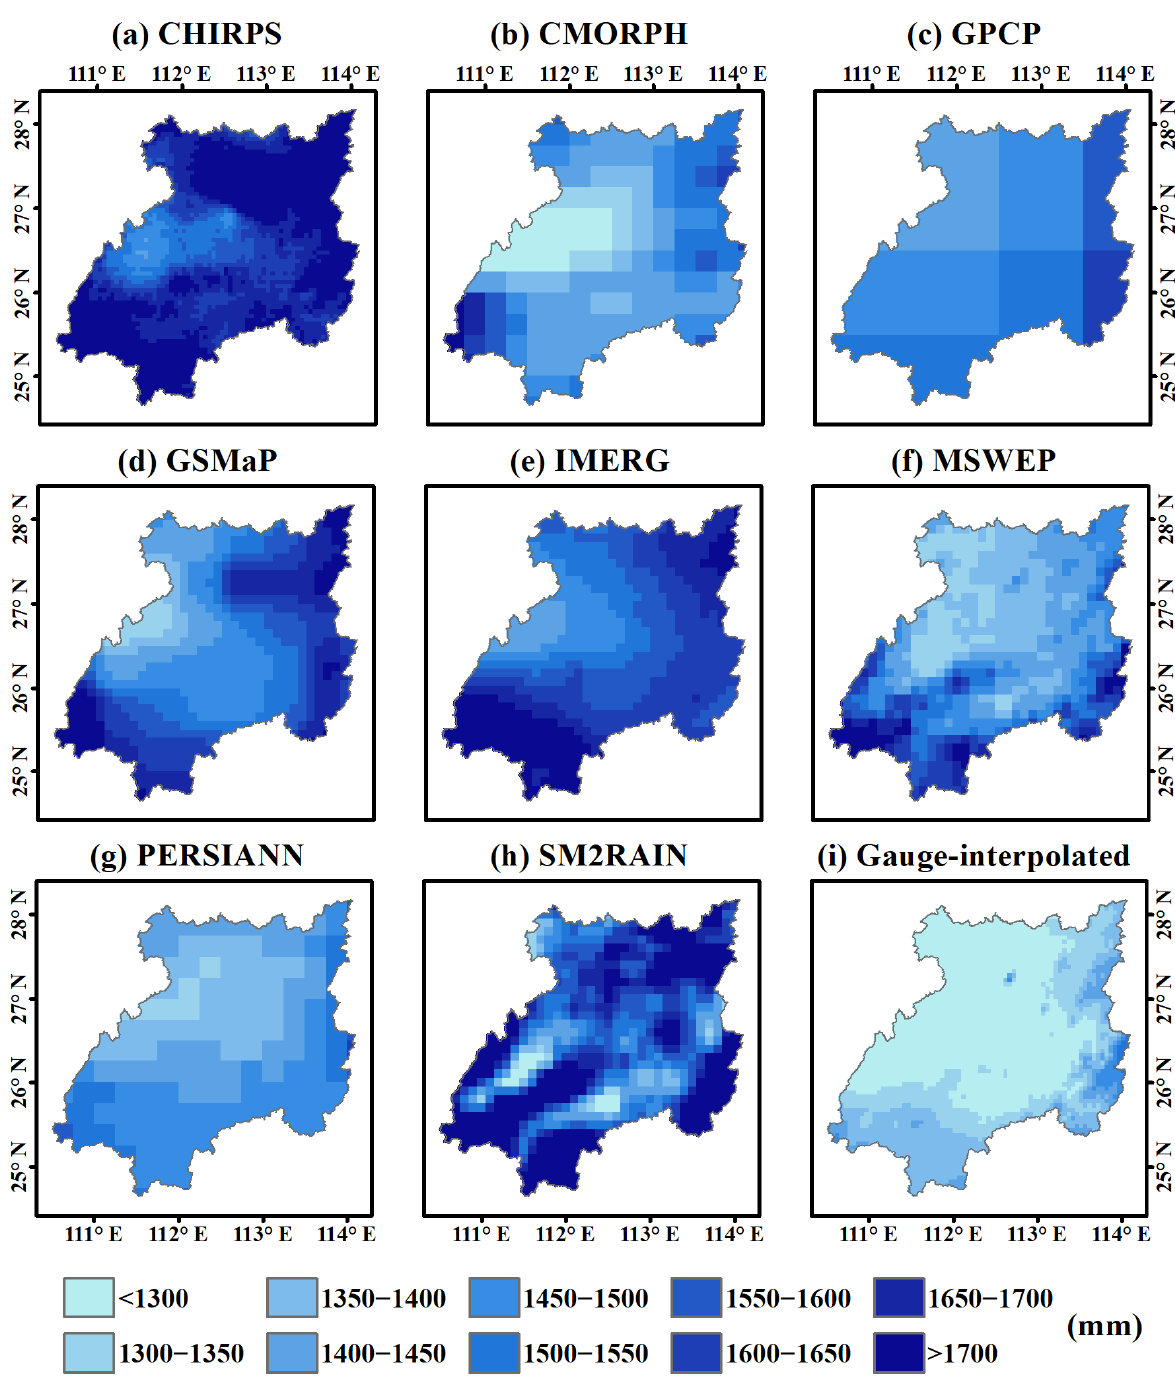
Figure 3. Spatial distribution of the annual average precipitation (from 2007 to 2020) for eight kinds of SPPs and gauge-observation interpolations. The satellite precipitations are at the original spatial resolution for each dataset.